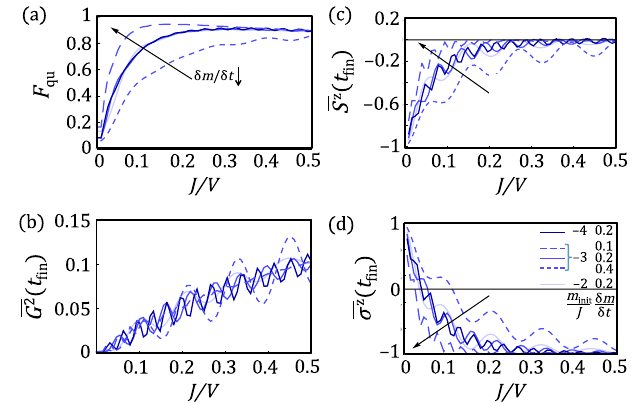
FIG. 11. Final state after a linear sweep for the minimal þ t(cid:8)m=(cid:8)t , with m ¼ implementation. We change m ð t Þ ¼ m init fin (cid:1) m , and keep V and J fixed. Solid lines from lighter to darker init =J ¼ (cid:1) 2 , (cid:1) 3 , (cid:1) 4 for (cid:8)m=(cid:8)t ¼ 0 : 2 V 2 = @ . Short shades: m init =J ¼ (cid:1) 3 and (cid:8)m=(cid:8)t ¼ 0 : 4 ð 0 : 1 Þ V 2 = @ . (long) dashed lines: m init The arrows show how the precision of the quench increases for smaller quench velocities (cid:8)m=(cid:8)t . The total times considered ¼ 15 @ =V (for m =J ¼ (cid:1) 3 , (cid:8)m=(cid:8)t ¼ 0 : 4 V 2 = @ ) range from t fin init =J ¼ (cid:1) 3 , (cid:8)m=(cid:8)t ¼ 0 : 1 ). For V= @ ¼ 2 (cid:4) 1 kHz to 60 @ =V ( m init [8,17], these correspond to 3.2–9.5 ms. (a)–(d) For a value of J=V * 0 : 1 , the final C - and P -breaking state is reached (a) with high fidelity, (b) good gauge invariance, and the desired behavior for (c) the gauge field and (d) the matter